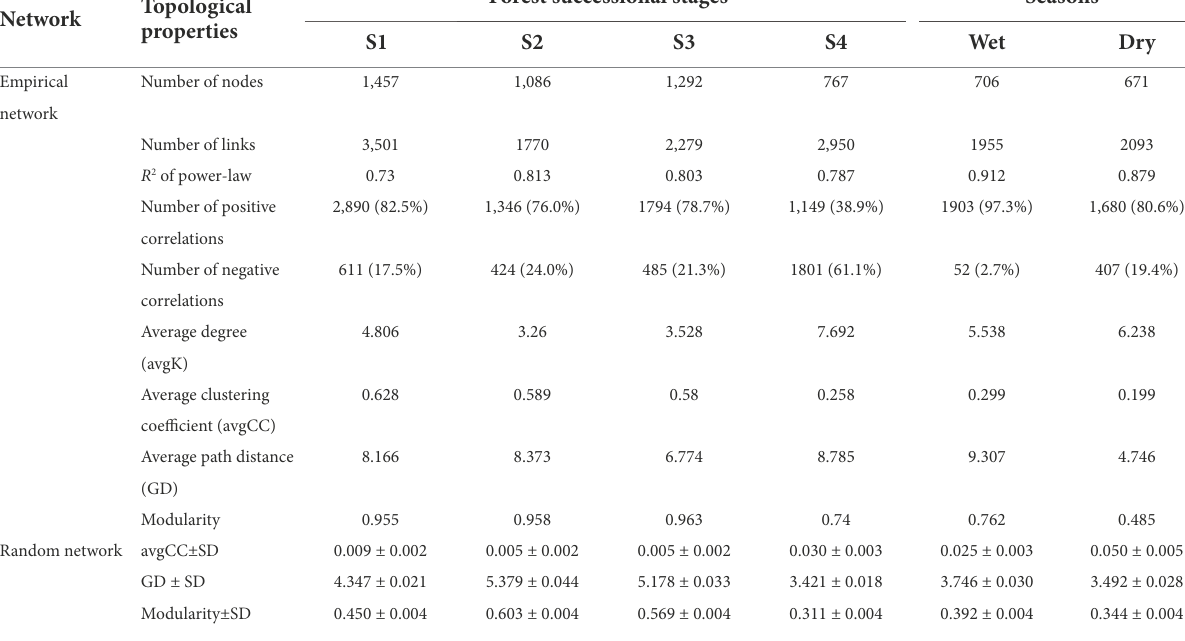
TABLE 2 Topological properties of the taxonomic network in soil bacteria.